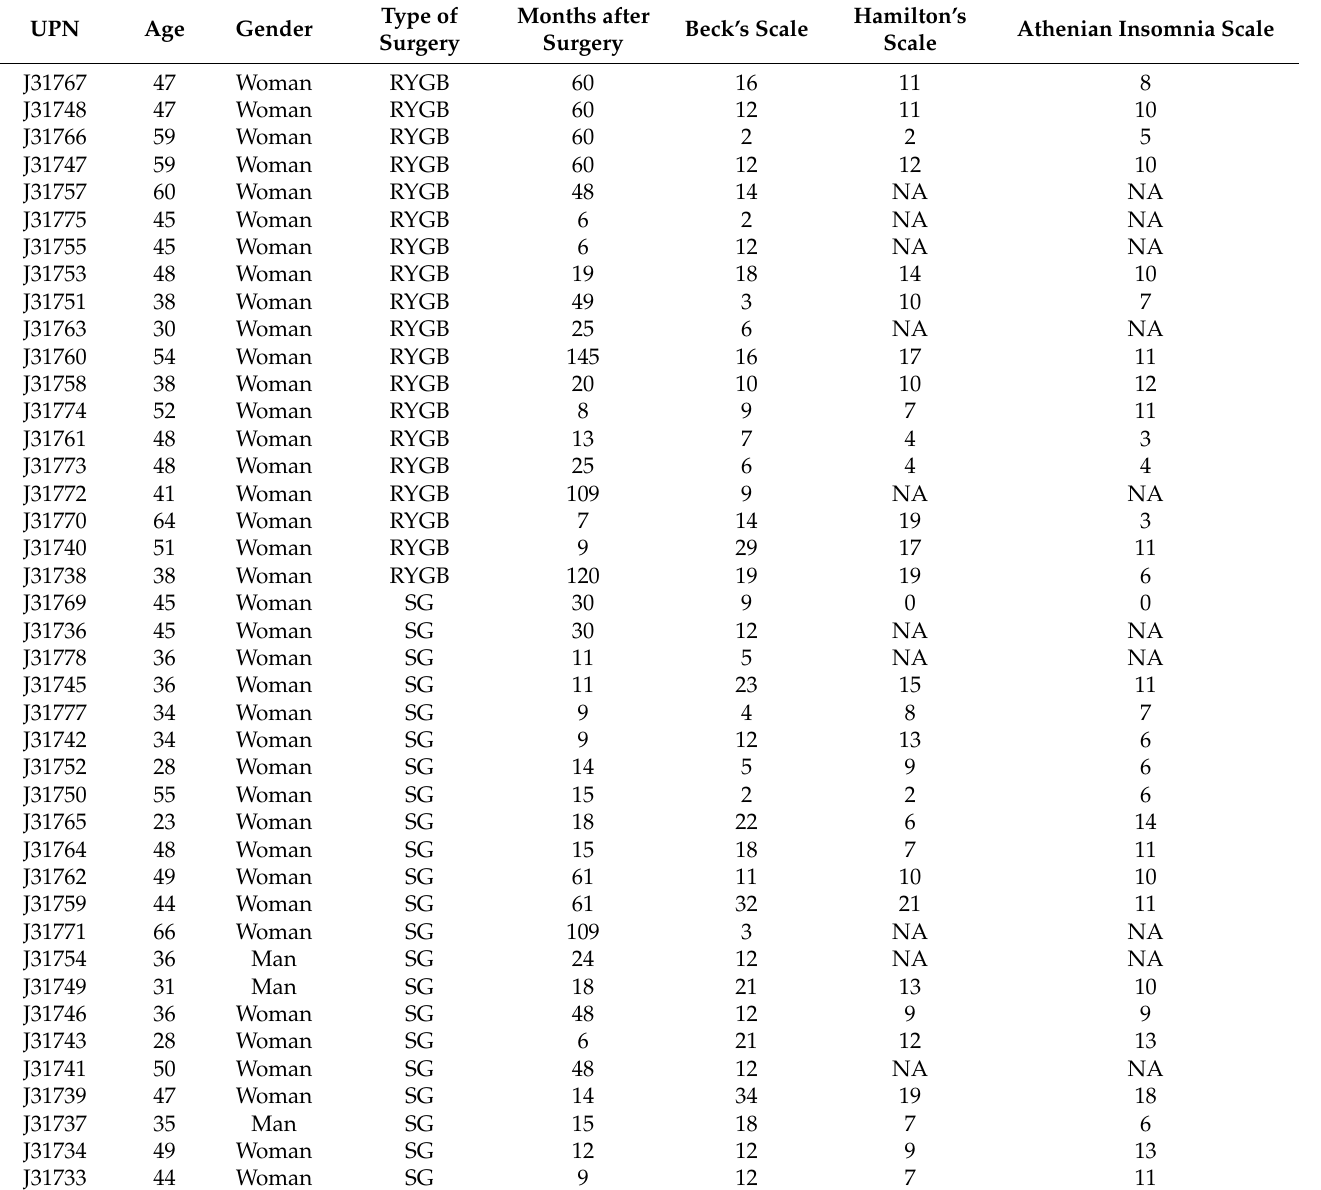
Table 1. Individual patients characteristics.